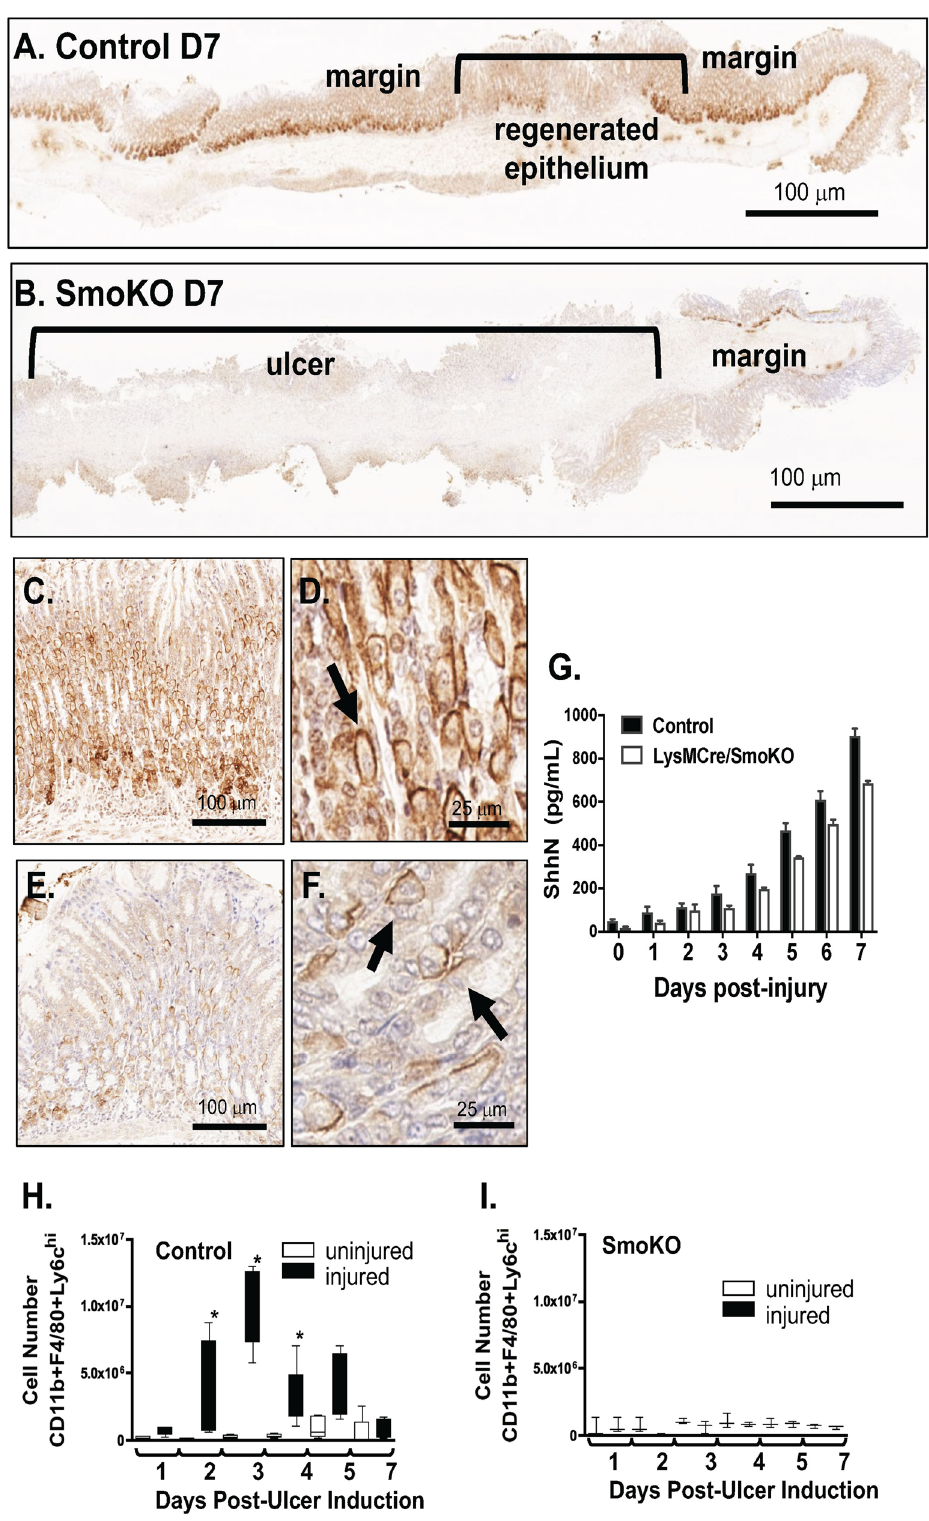
Fig. 2 Expression of Shh and macrophage in fi ltration in control and LysMCre/SmoKO mice. Immunohistochemistry of Shh expression in A control and B LysMCre/SmoKO mouse stomachs. Shh expression at the ulcer margin of C , D control, and E , F LysMCre/SmoKO mouse stomachs. G Shh concentrations (pg/mL) measured in plasma collected from in control and LysMCre/SmoKO mice. Macrophage numbers (CD11b + F4/80 + Ly6C hi ) within the uninjured and injured gastric epithelium of H control and I LysMCre/SmoKO mice 1 – 7 post-ulcer induction. * P < 0.05 compared to day 1 post-injury, n = 6 mice per group. Data are shown as the mean ±